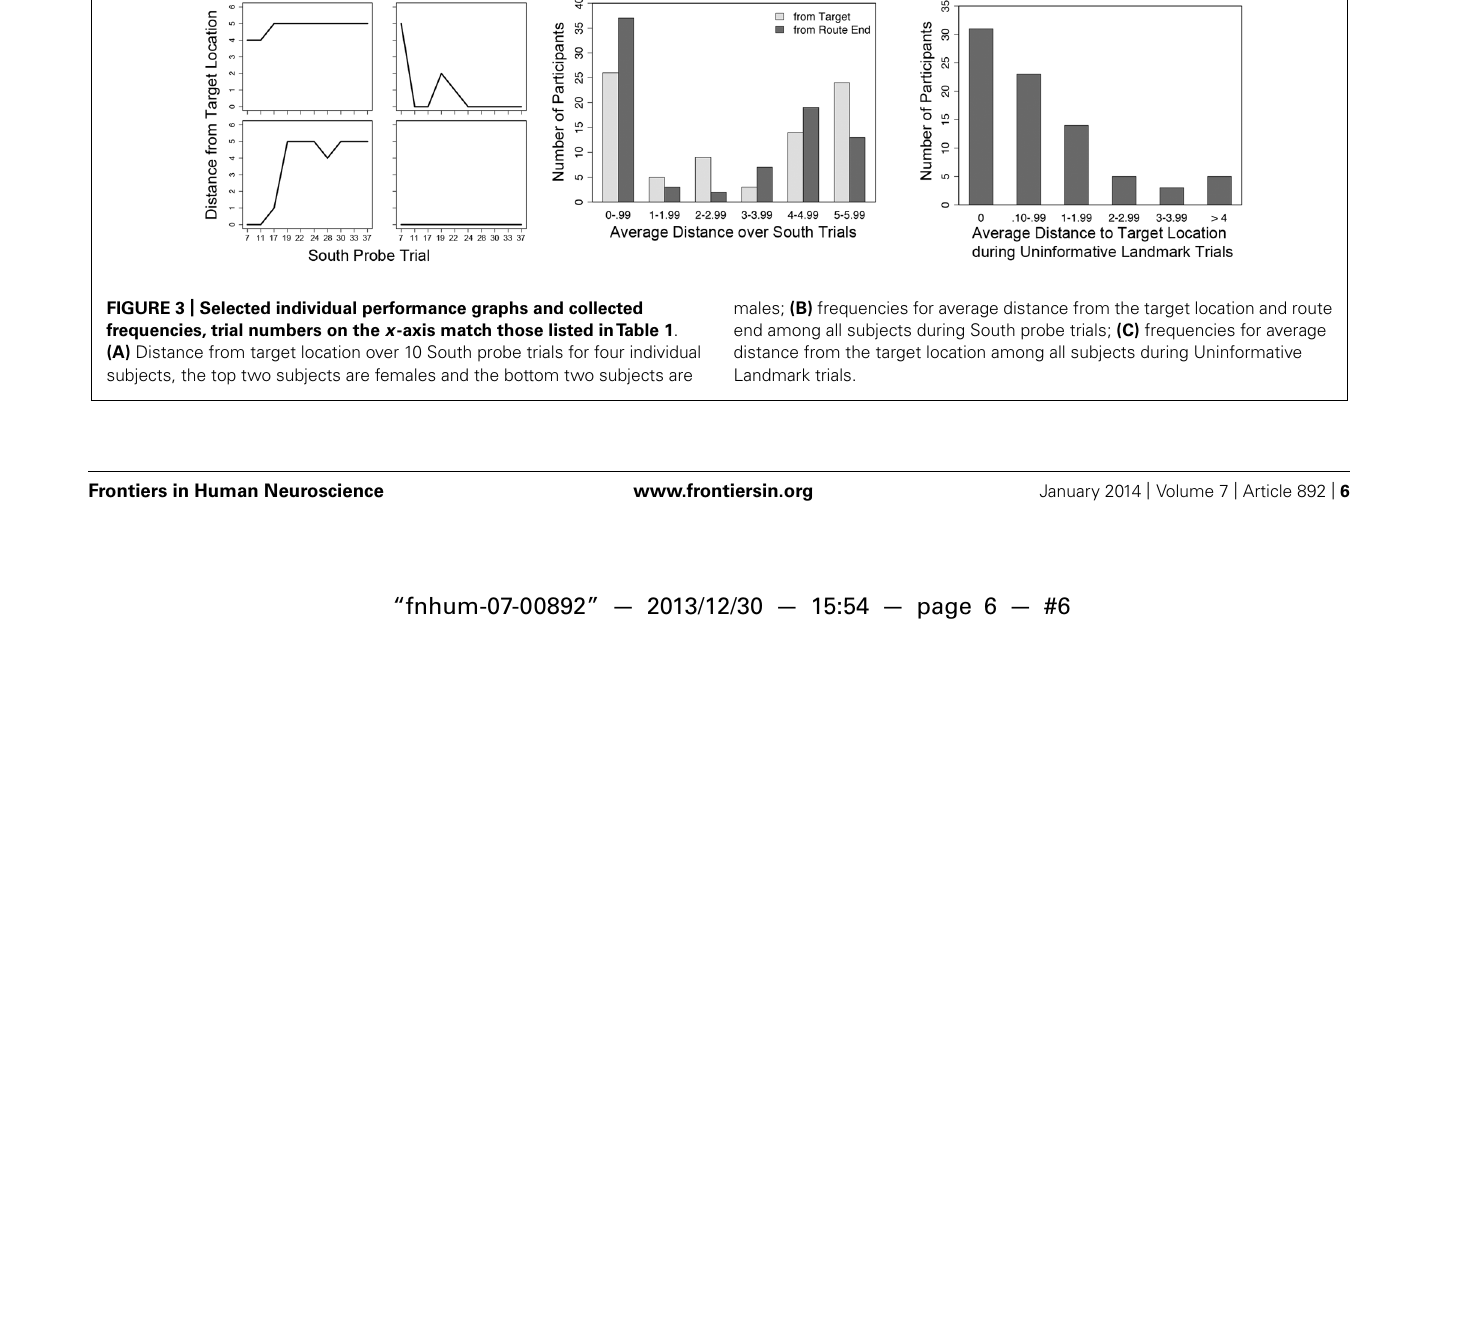
Level 1 – Within individuals (i.e., across trials)